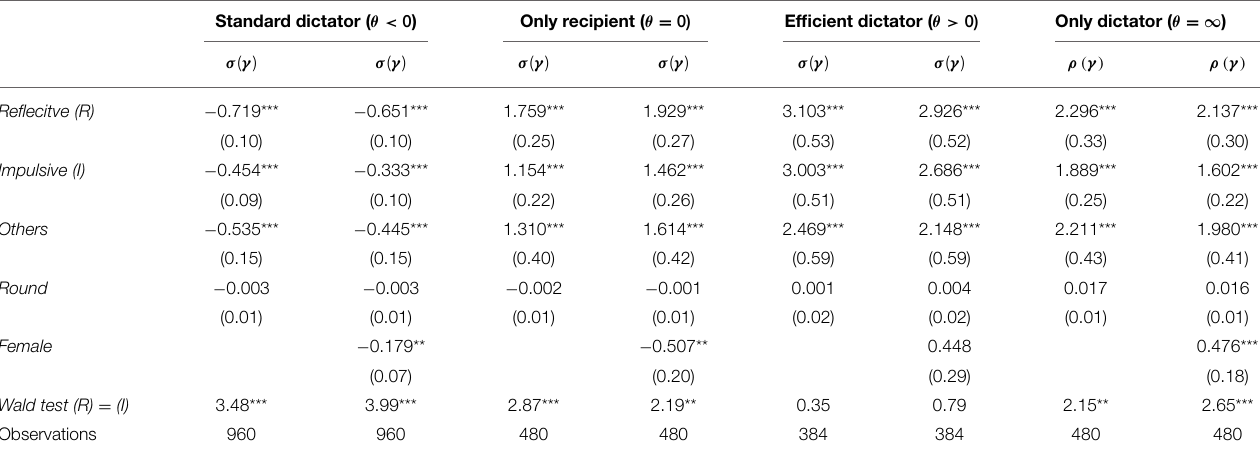
TABLE 3 | Random-effect tobit regression for σγ and ργ in each type of